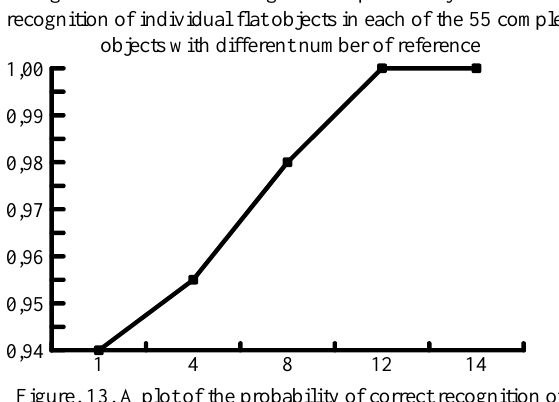
Figure. 13. A plot of the probability of correct recognition of individual flat objects in a complex object on the number of standards